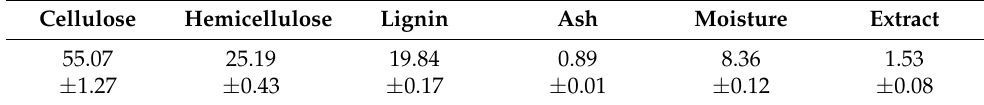
Table 1. Content of bagasse biomass